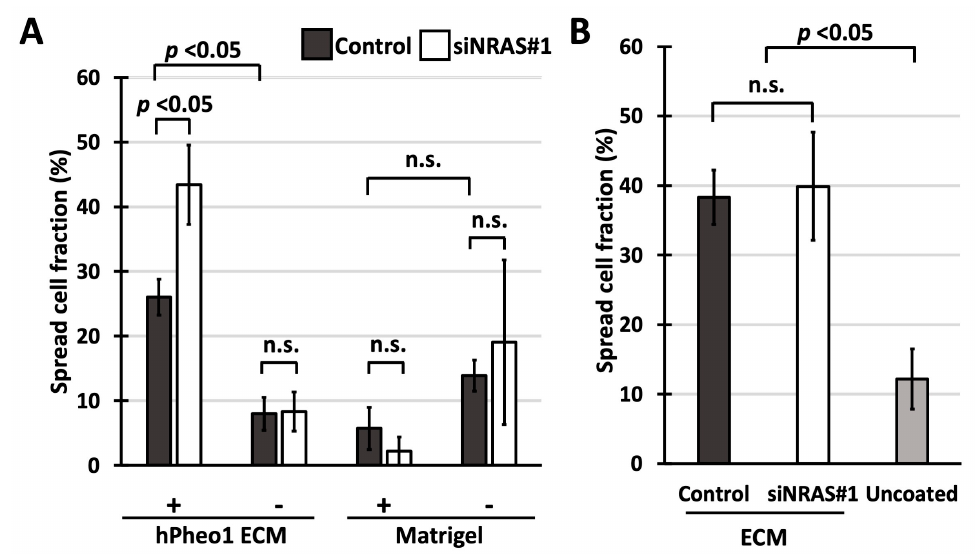
Figure 4. ( A ) and ( B ) Fraction of cells exhibiting spread morphology presented as percentages (mean ± standard deviation) in spreading assays using cell culture-derived ECMs and Matrigel. ( A